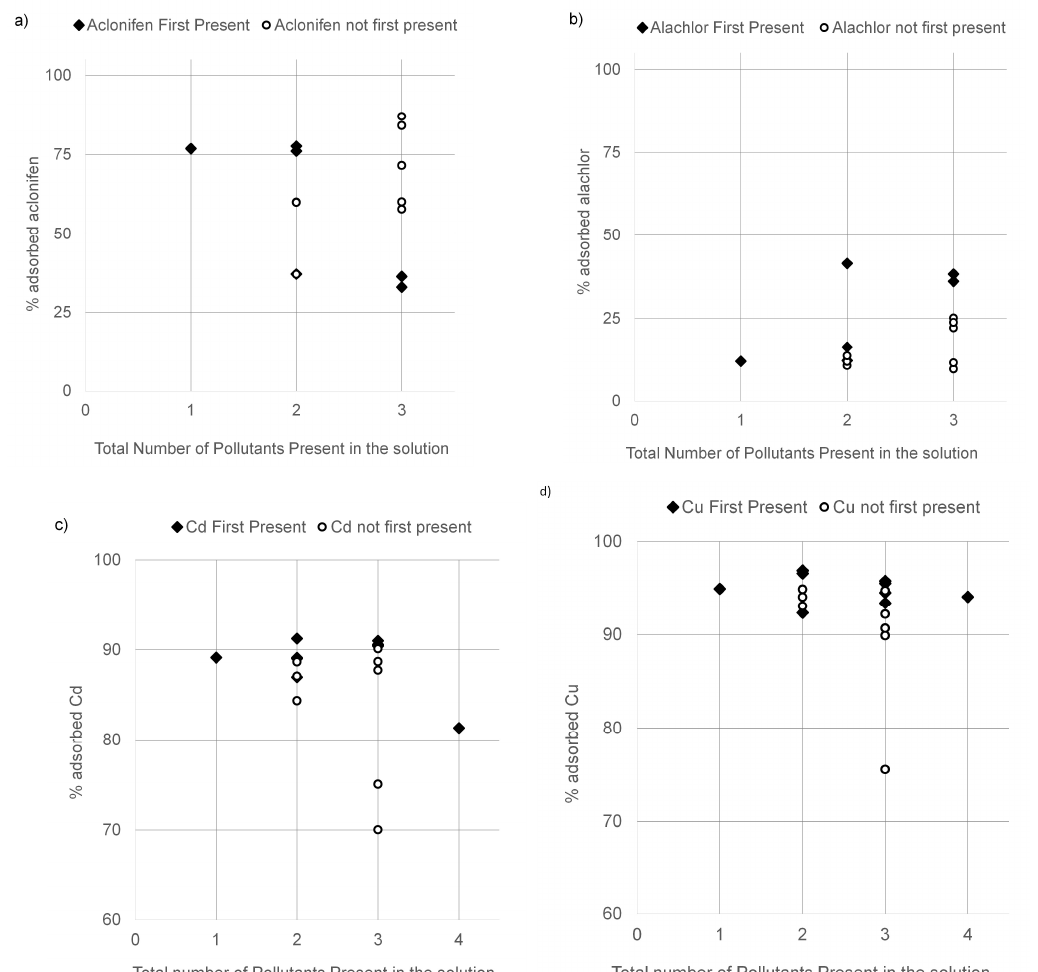
Figure 8. Percentage of adsorption of Aclonifen ( a ), Alachlor ( b ), Cd ( c ) and Cu ( d ) as a function of the total number of pollutants present in the solution. Present first: the studied pollutant was the first added to a solution; Not present first: the studied pollutant was added to a solution where one or more other pollutants were already present.